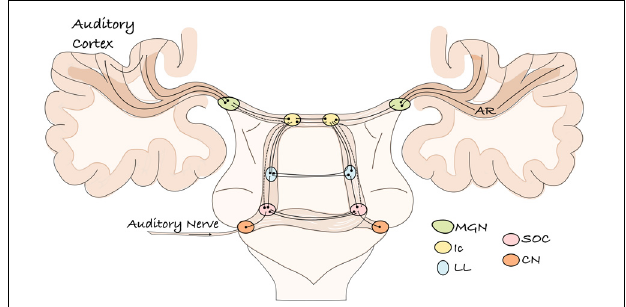
FIGURE 1 | A schematic representation of the ascending human auditory system. The auditory information enters through the auditory nerve and reaches the cochlear nucleus. From here, various projections transmit the information to different brainstem relays of both hemispheres and then to the auditory cortex. The lemniscal pathway is represented by solid lines; the extra-lemniscal pathway by dashed lines. CN, cochlear nucleus; SOC, superior olivary complex; LL, lateral lemniscus; Ic, inferior culliculus; MGN, medial geniculate nucleus; AR, acoustic radiation.